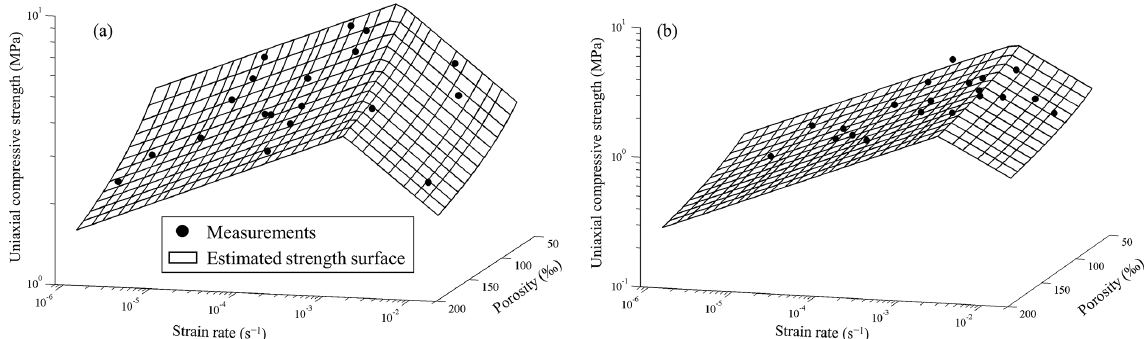
Figure 11. Three-dimensional surfaces of uniaxial compressive strength of (a) vertically and (b) horizontally loaded samples varying with strain rate and